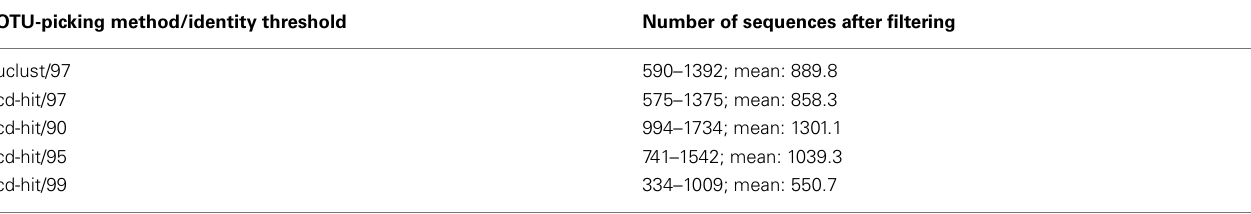
TableA1 |The range and mean of the number of sequences in each sample after applying the following filtering regime to the sequence dataset: removing OTUs represented by a single sequence, and removing OTUs present in only one sample.